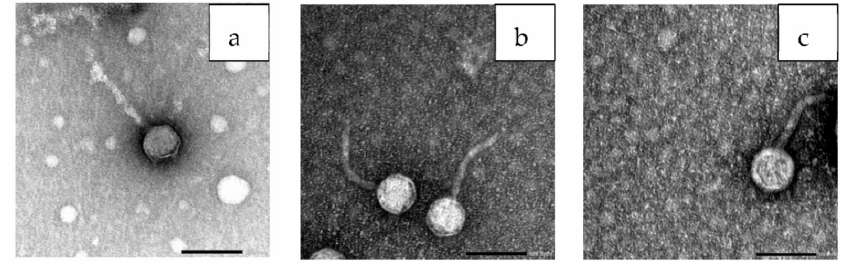
Figure 5. TEM images showing the morphology of the individual phages: ( a ) ZCEC10 phage, ( b ) ZCEC11 phage, and ( c ) ZCEC12 phage, scale bar represents 100